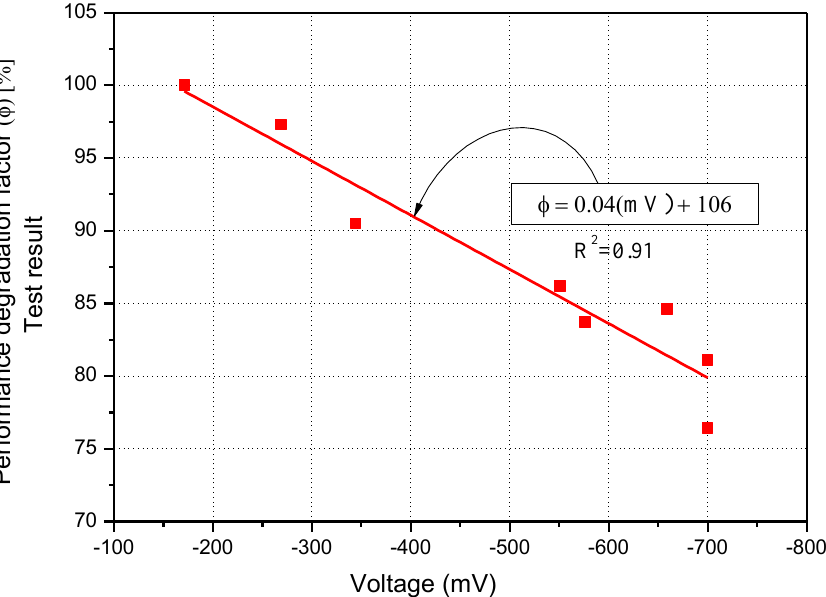
Figure 18. Relationship between bonding factor ( β ) and performance reduction factor ( ϕ ) of shear beam specimens (FEM analysis).